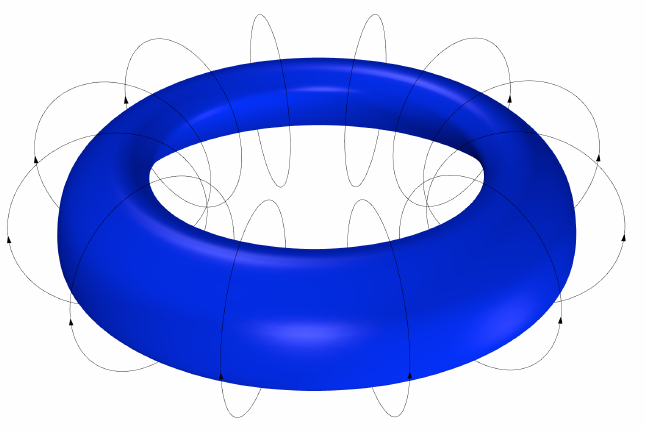
Figure 9. Schematic representation collapsing vortex ring: blue surface represents the collapsing ring, black arrows represent the liquid